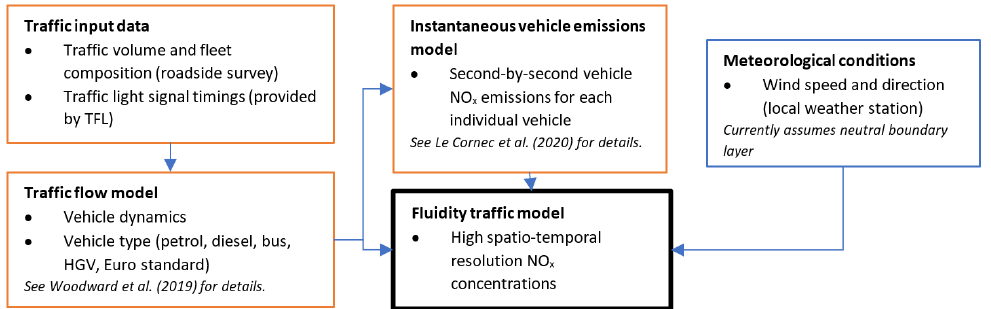
Figure 2. Flow chart of methodology used to simulate high spatio-temporal NO x concentrations from traffic emissions. TFL stands for Transport for